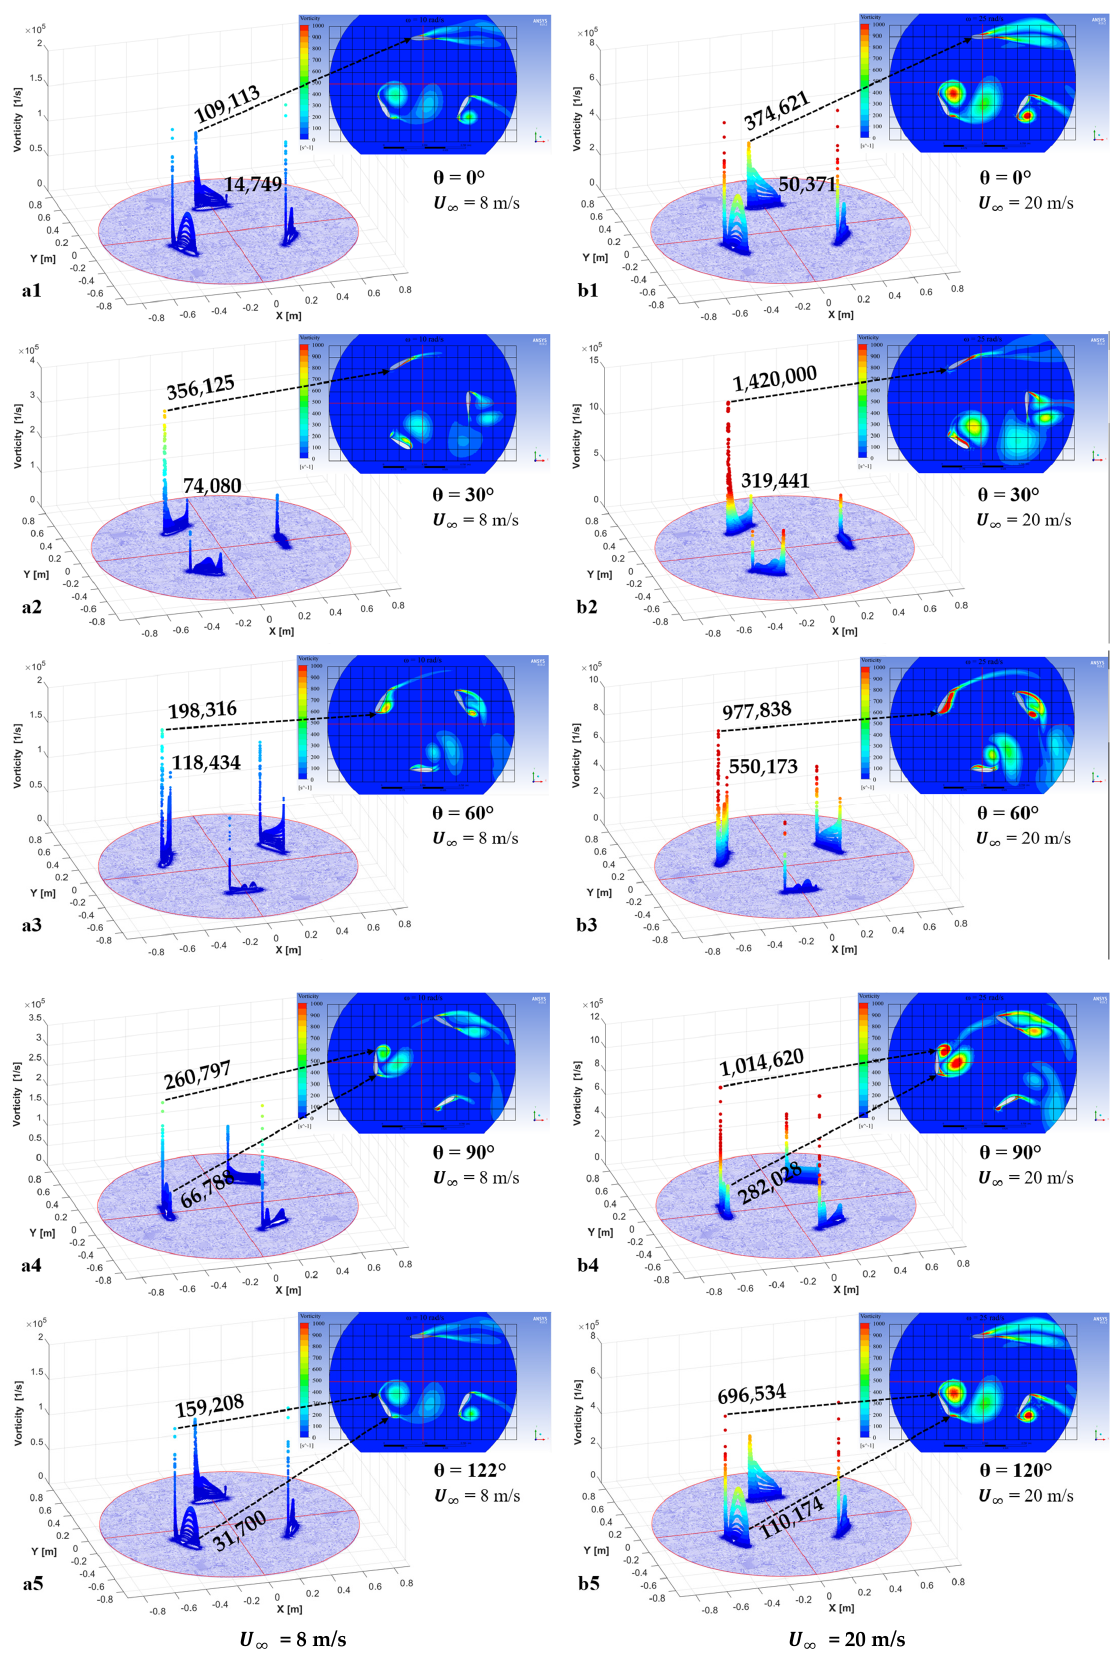
Figure 16. Vorticity Values at the LE and TE of Blade 1 at 𝜆 =0.5 for ( a1 – a5 ) 𝑈 (cid:2998) = 8 m/s and ( b1 – b5 ) 𝑈 (cid:2998) = 20 m/s. U ∞ = 20